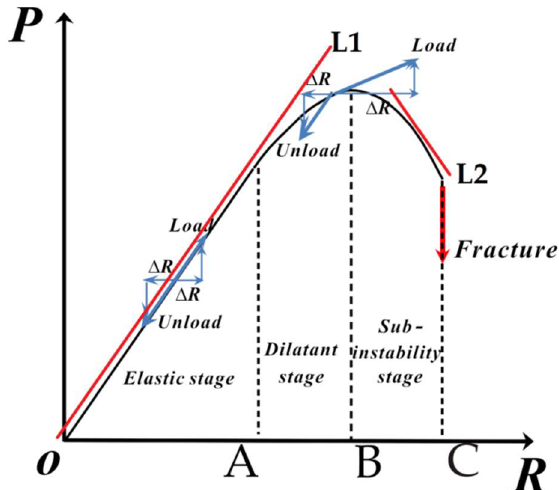
Figure 8. Typical rock constitutive curves and behavior. P and R represent, respectively, the load and response. In stage OA, the response (ΔR) to the small changes of ΔP in the loading and unloading are almost the same. At stage AB, the response to loading is significantly greater than unloading, and stage BC is characterized by macroscopic damage. L1/L2 is the auxiliary line.